Question: Which kind of chart has been used to present this data?
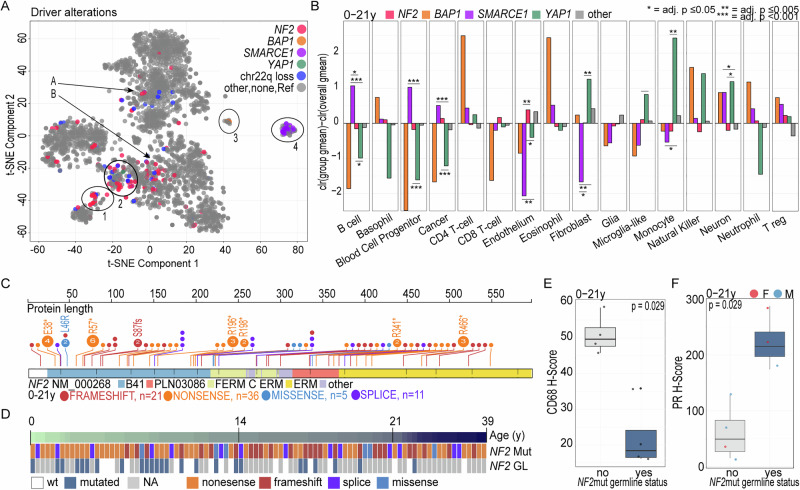
Answer: scatter